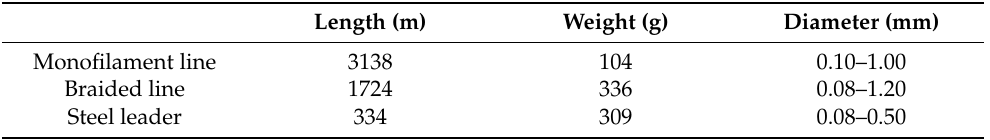
Table 3. Length and weight of the collected fishing line and steel leaders. Note that fishing lines can consist of either polyamide, polyethylene, or other polymers. Steel leader material can be manufactured with different tempering and can contain components such as zinc and nickel, and it can be coated with plastics. Diameter gives the minimum and maximum measured diameter of the line or steel leaders